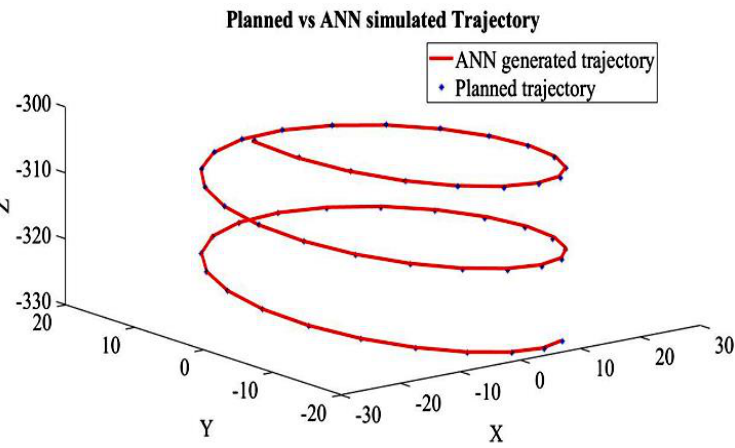
Figure 13. Desired and MLP solved